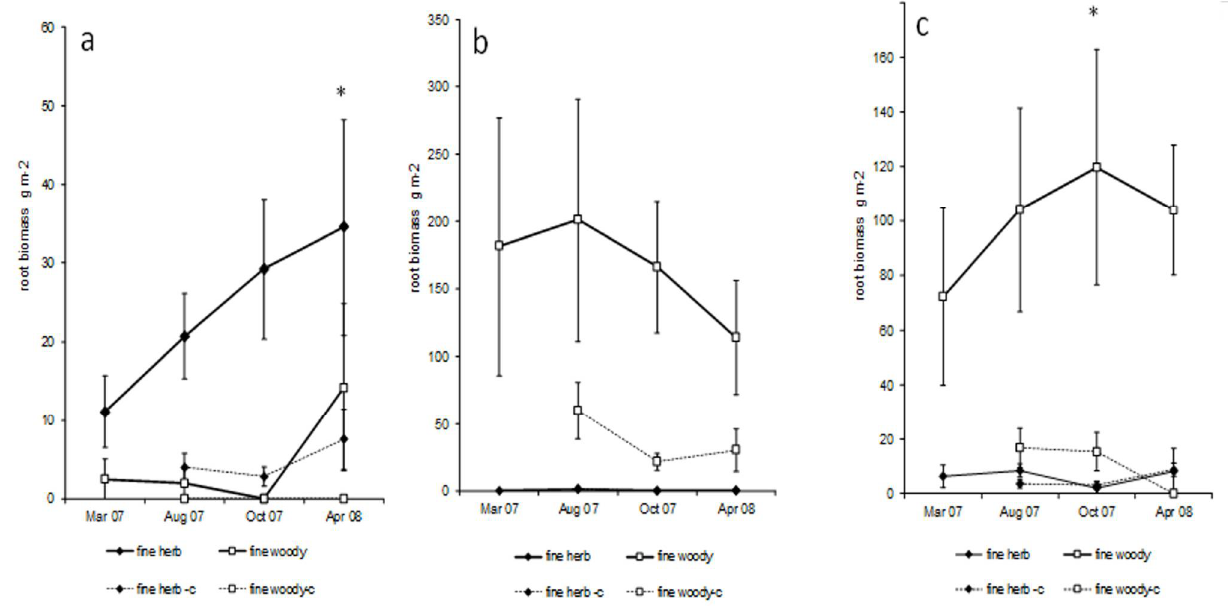
Figure 3. Seasonal dynamics of fine woody and herb roots in soil and in ingrowth cores (labeled -c in the legend) in post-mining sites created 16- ( a ), 22- ( b ) and 45-years ago ( c ) in the Sokolov coal mining district and left to develop by spontaneous succession. An asterisk means significant difference from the first sampling